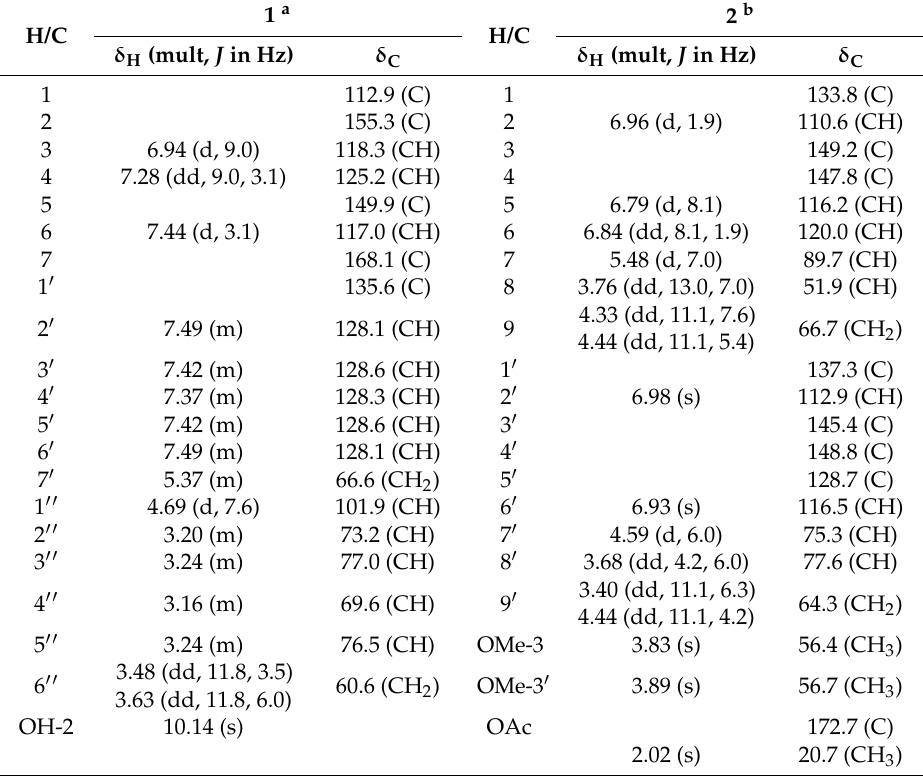
Table 1. The 1 H (500 MHz) and 13 C (125 MHz) nuclear magnetic resonance (NMR) data of compounds 1 and 2